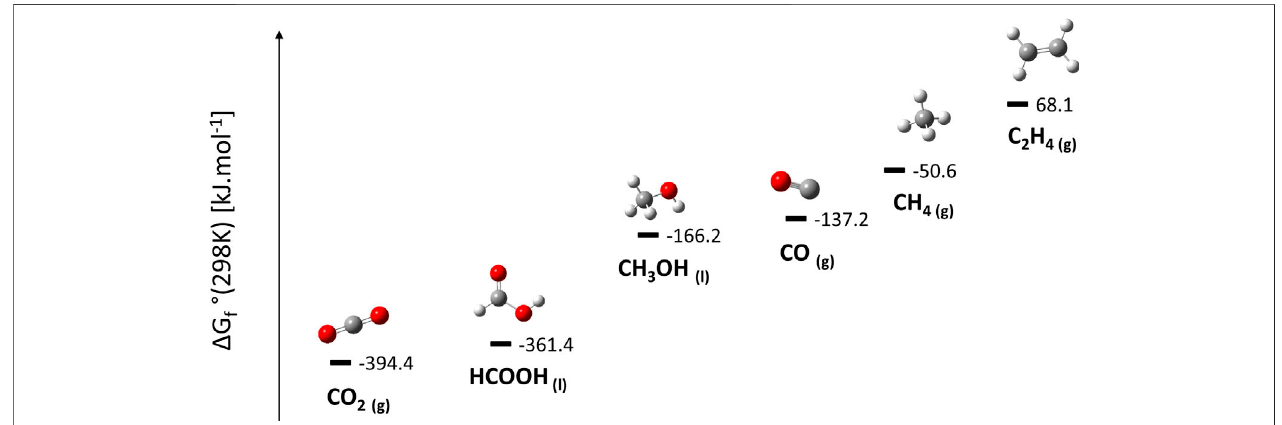
FIGURE 2 | Standard Gibbs free energy of formation (at 298 K), expressed in kJ mol − 1 , of CO 2 and possible reduction products.